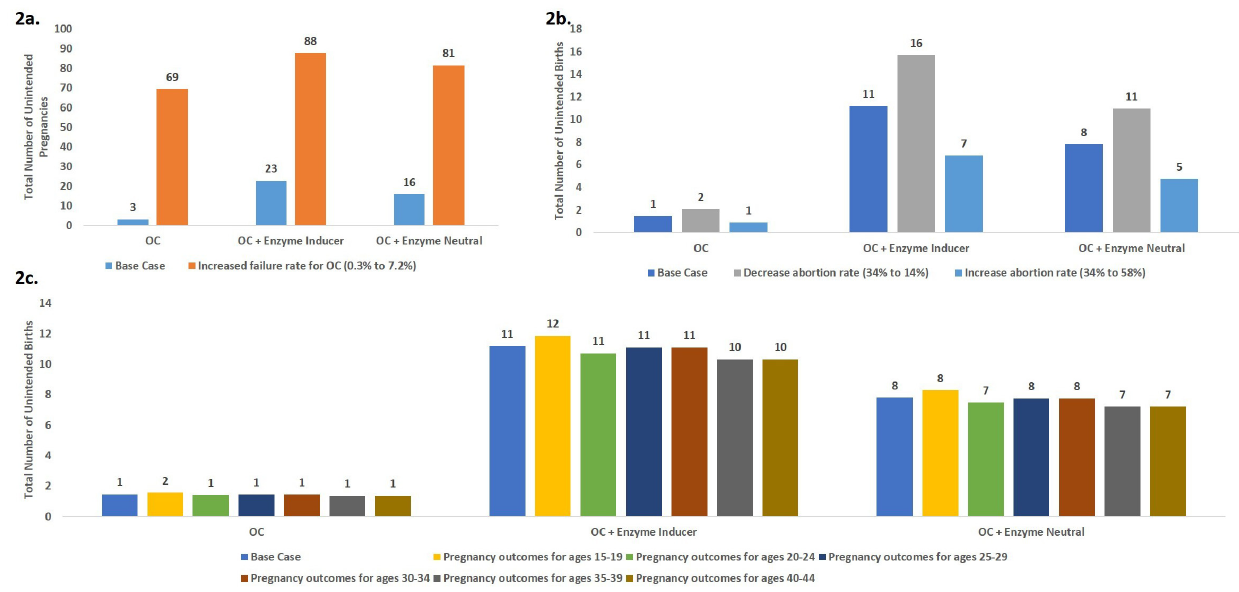
Figure 2. Scenario analysis: Comparison of key health outcomes for each scenario. Scenario 1. Increasing oral contraceptive failure rate; Scenario 2. Increased or Decreased Abortion Rate; Scenario 3. Age-specific patterns of pregnancy outcomes.